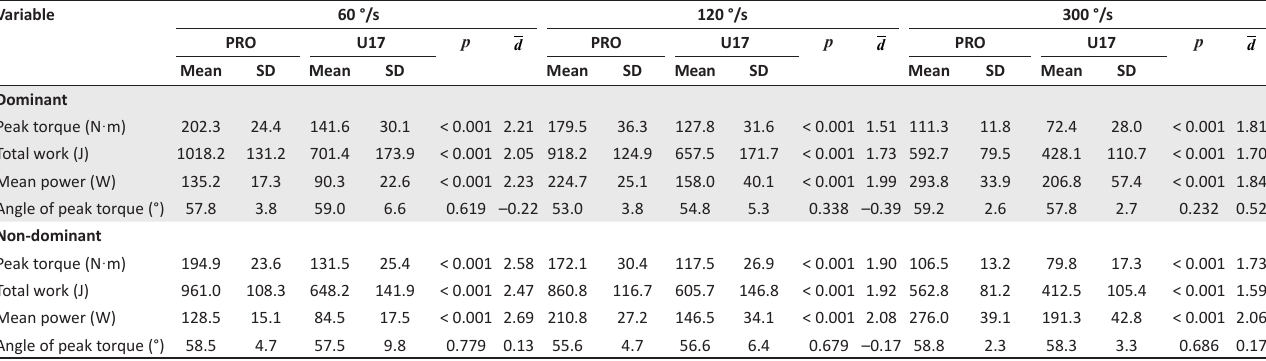
TABLE 1: Isokinetic parameters of extensor muscle assessments. Variable